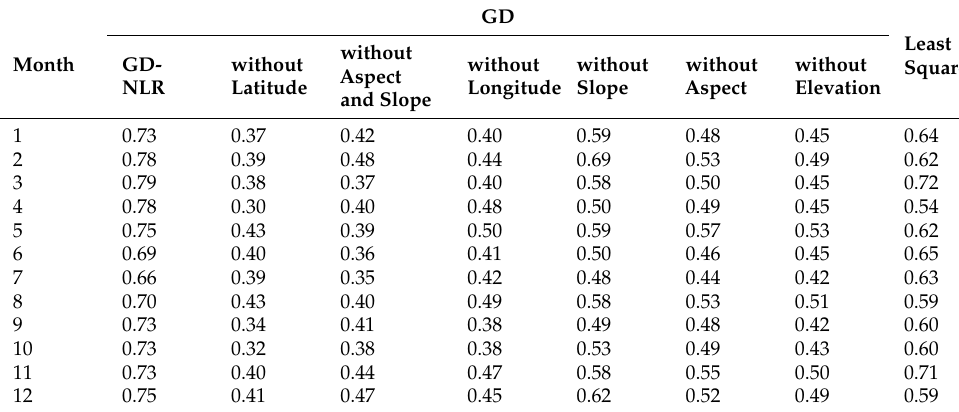
Table 2. Accuracy test (R 2 ) of GD-NLR